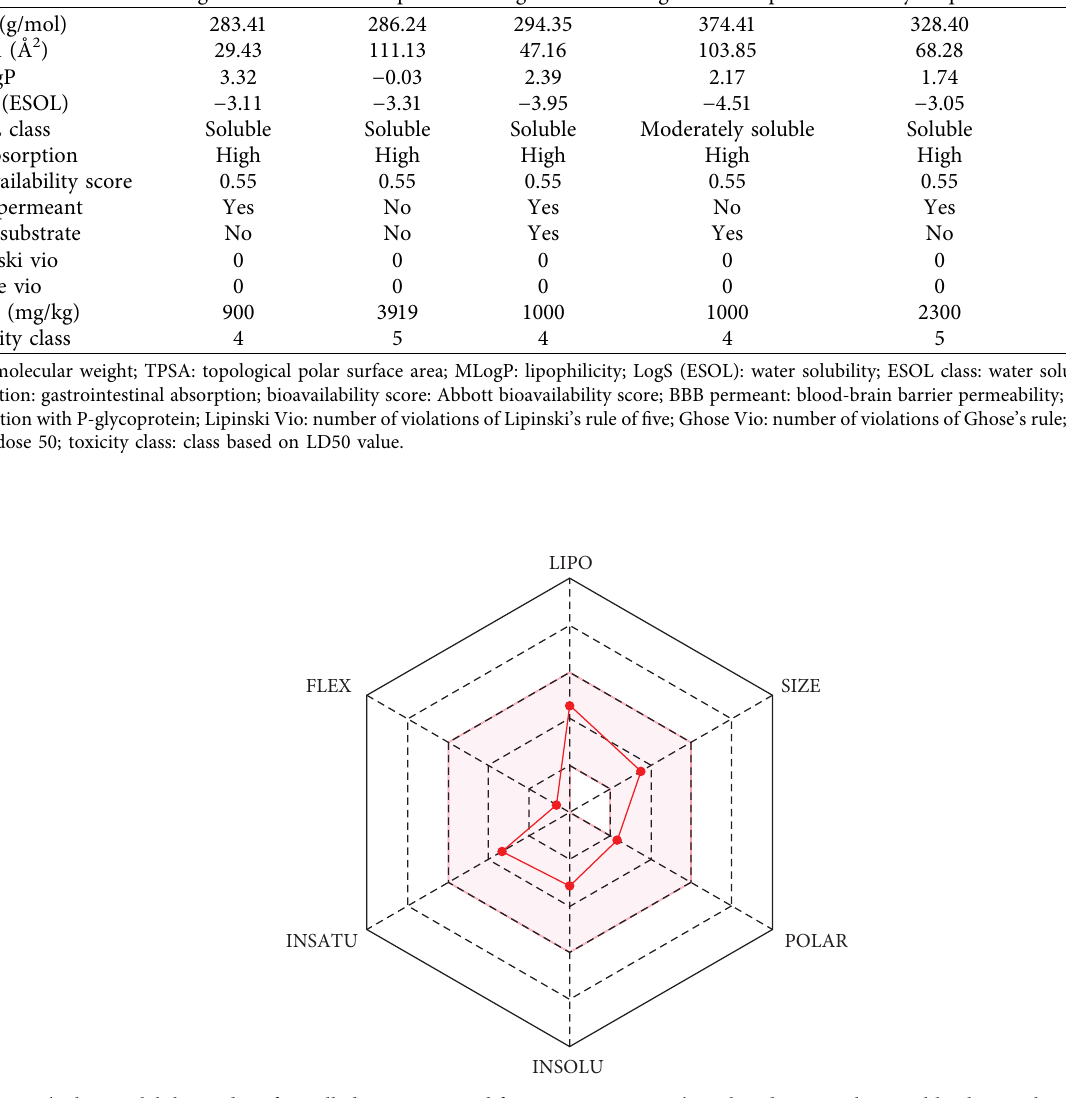
Figure 3: Te bioavailability radar of Nigelladine A retrieved from SwissADME. Te colored zone is the suitable physicochemical space for oral